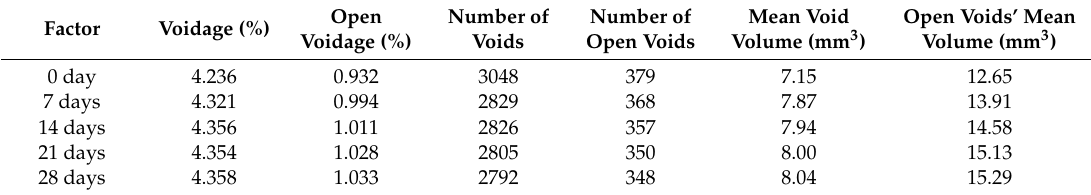
Table 11. Void Calculation Data for the AC2 Specimen (Under Salt Water Soaking Conditions).